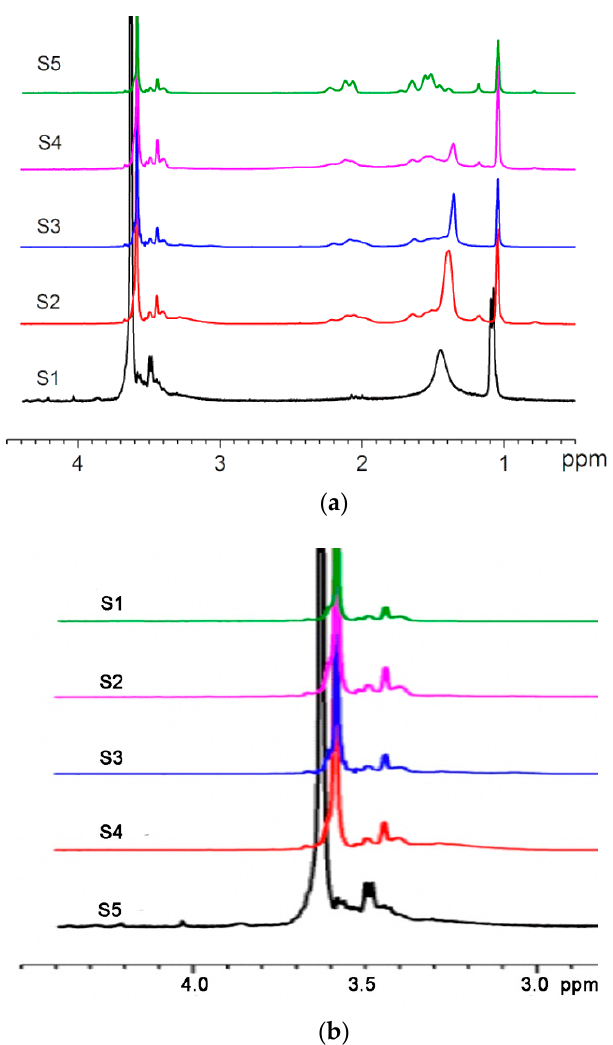
Figure 2. 1 H NMR spectra for the five prepared polymers: ( a ) 1.0–4.0 ppm; ( b ) 3.0–4.0 ppm.